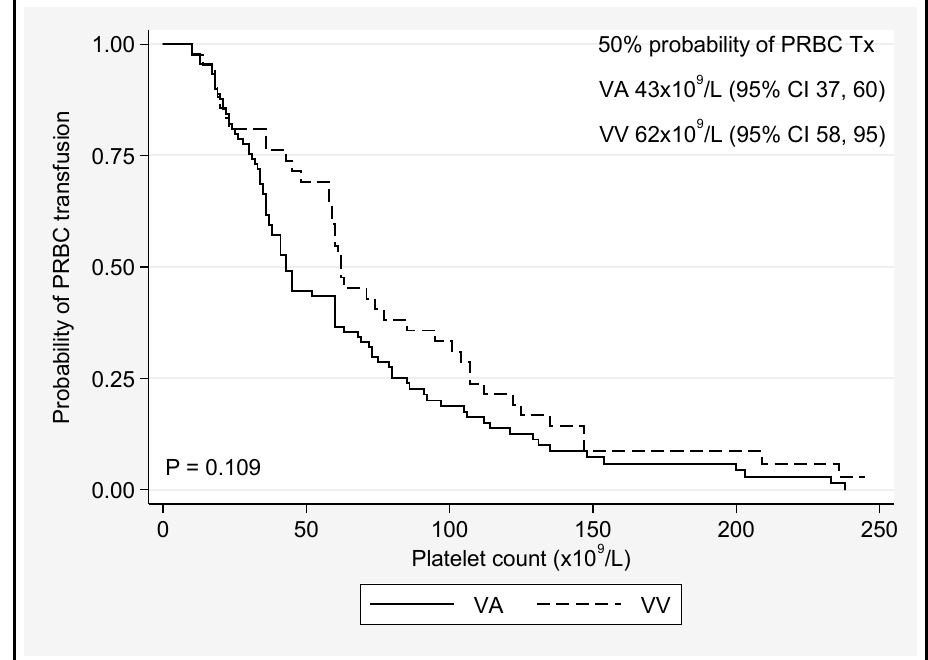
Figure 4. Platelet count cut-off value associated with PRBC transfusion in VA and VV ECMO patients. Tx = transfusion.